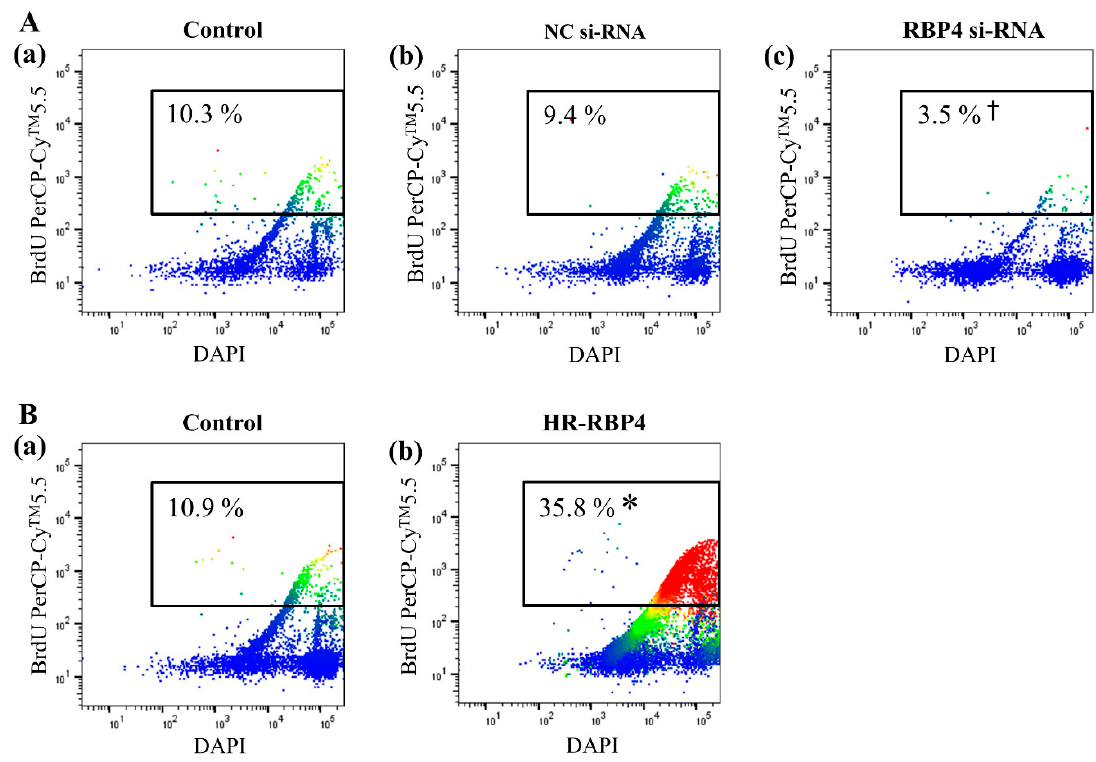
Figure 5. Cellular proliferation analyzed using flow cytometry with BrdU staining in endometrial stromal cells following treatment with the vehicle ( a ), transfection with the negative control siRNA ( b ) or RBP4 siRNA ( c ) ( A ), or treatment with HR-RBP4 ( Bb ). † p < 0.05 compared with vehicle group ( Aa ) as well as negative control siRNA transfection group ( Ab ). * p < 0.05 compared with the control group ( Ba ). NC: negative